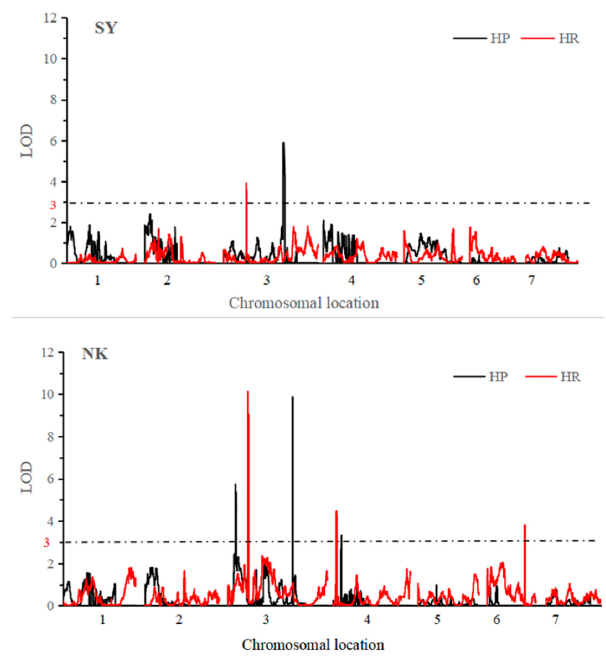
Figure 3. QTL analysis of thermotolerance in cucumber seedlings. The x-axis indicates the genetic position of each chromosome, the y-axis indicates the LOD value. SY: experiment conducted at Sunyi, where seedlings were exposed to short-term extreme heat stress, NK: experiment conducted at Nankou, where seedlings were exposed to long-term mild heat stress.